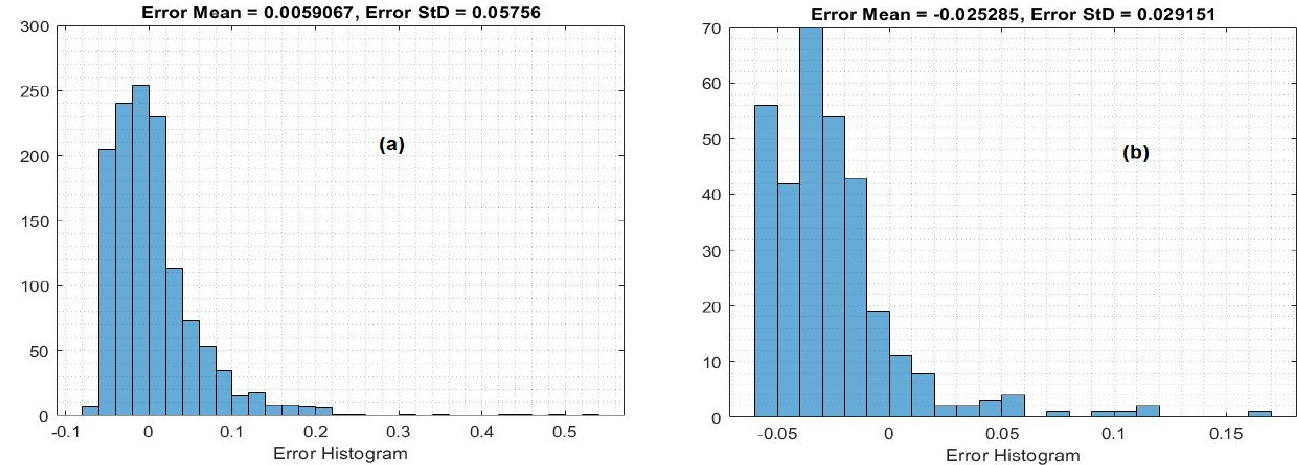
Figure 12. Error histograms of the LSTM model in predicting the prices of the EOS cryptocurrency in ( a ) training and ( b ) testing.